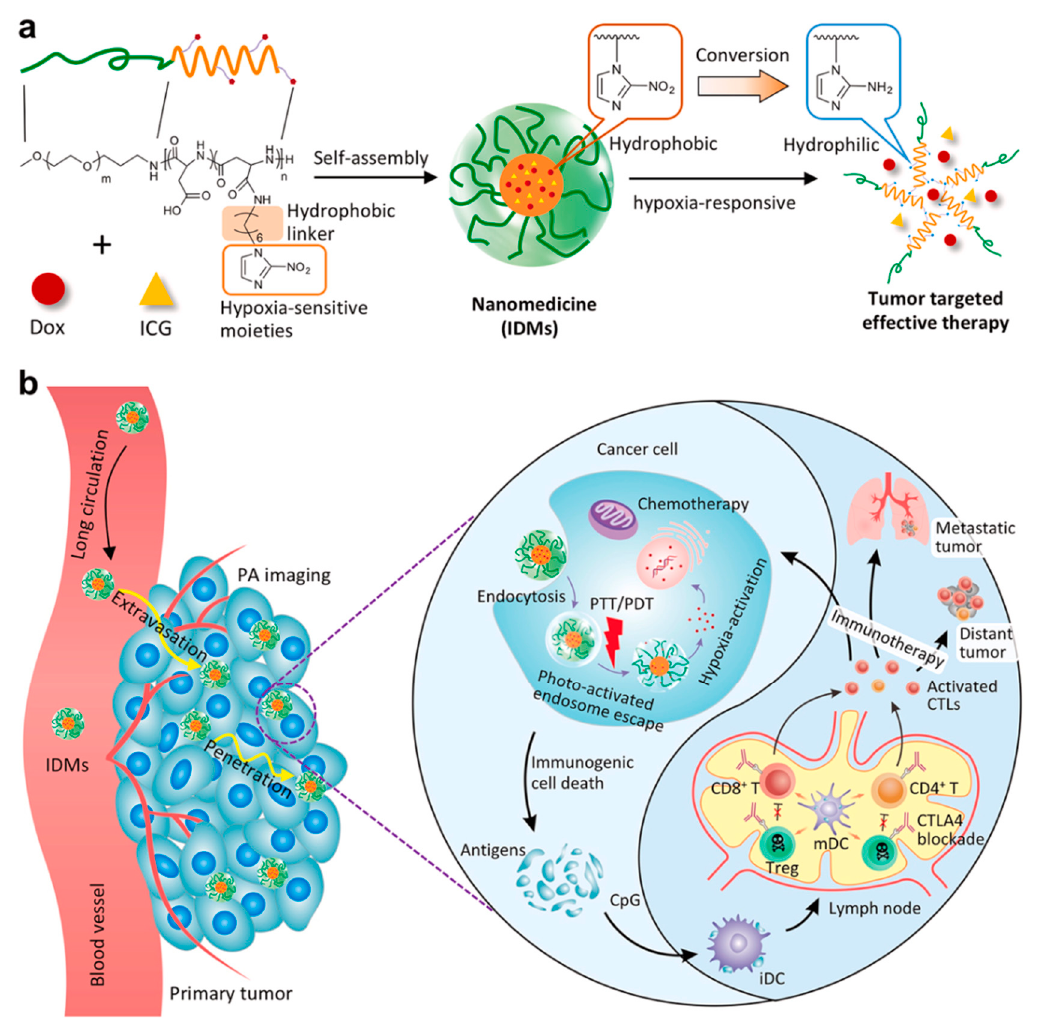
Figure 5. Scheme of hypoxia-responsive micelles in advanced breast cancer. ( a ) Nanoparticle formulation; ( b ) The mechanism of the hypoxia-responsive nanoparticle in treating advanced breast cancer. Reprinted with permission from Ref.[51]. Copyright 2021, Mi, P.